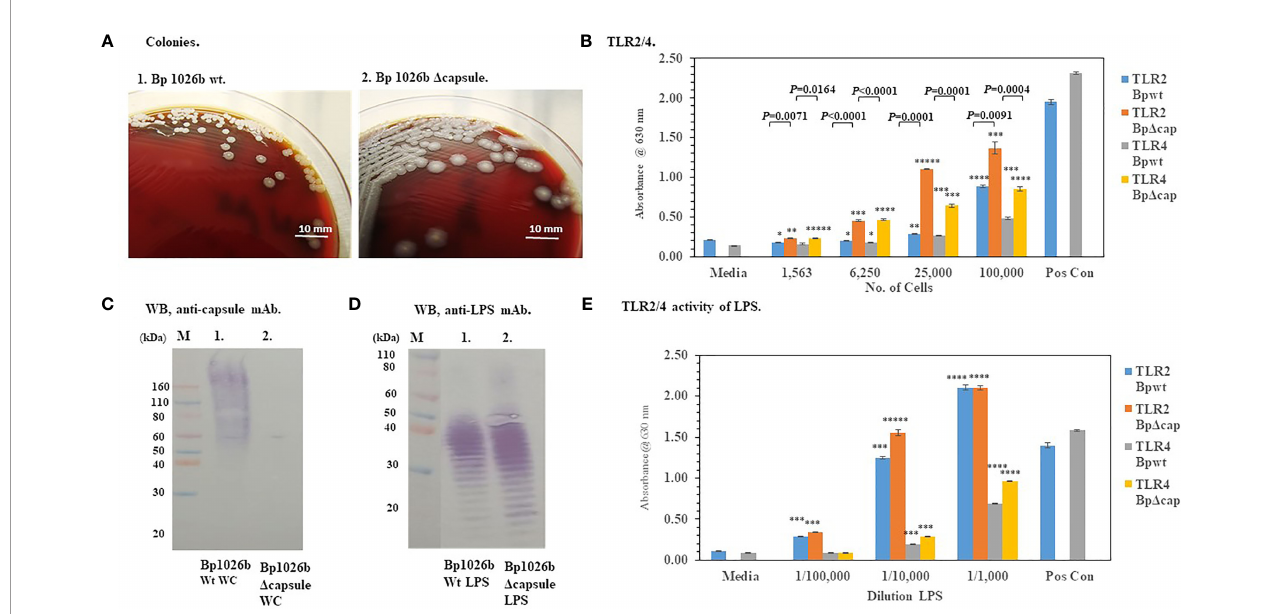
FIGURE 5 | The capsule of Bp 1026b mitigates the activation of TLR2 and TLR4. Bp 1026b (Wt) and Bp 1026b ( D wcb R- wcb A, D capsule mutant) were grown for ~48 h on SBA at 37°C. (A) Colony morphology of Wt and D capsule mutant. (B) Bacterial cell suspension were made in PBS and used to inoculate HEK293-TLR2 or -TLR4 cells and activation of TLRs measured after 18 h. Samples were performed in triplicate, and results represent one of two repeats. Signi fi cant differences in activity between Wt and capsule mutant are shown above the results. (C) Western blot (WB) analysis of whole-cells (WC) of Bp 1026b Wt and Bp 1026b D capsule mutant probed with an anti-capsule monoclonal antibody (mAb) (AVA5). (D) WB analysis of LPS extract from Bp 1026b Wt and Bp 1026b D capsule mutant probed with an anti-LPS mAb (11G3-1). (E) Activation of TLR2 or TLR4 by LPS extract from Bp 1026b Wt and Bp 1026b D capsule mutant. Samples were analyzed in triplicate and results represent one of two independent repeats. Results of TLR activation (B, E) are presented as geometric mean with standard error of the mean. Media controls were PBS, and positive controls (Pos Con) were HKLM (2 x 10 6 cells) for TLR2, and E. coli LPS (0.2 ng) for TLR4. Signi fi cant values compared to media control are shown: * P ≤ 0.05; ** P ≤ 0.01; *** P ≤ 0.001; **** P ≤ 0.0001; ***** P ≤